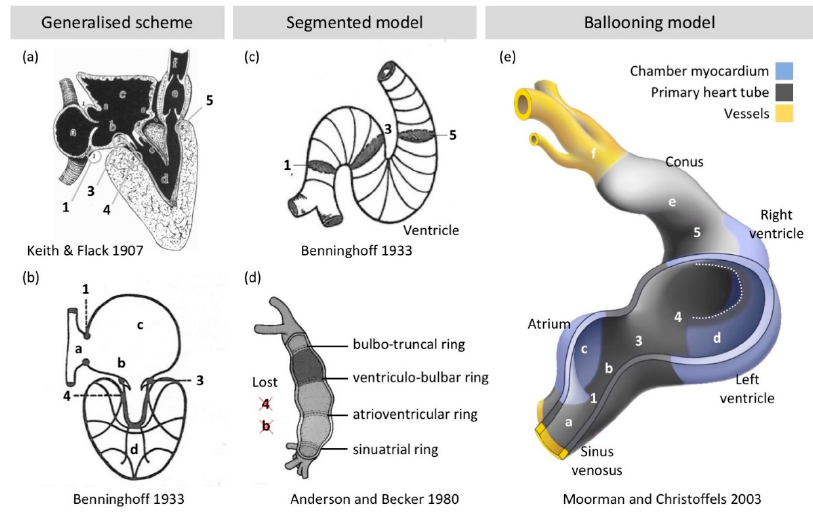
Figure 2. Building plan of the heart. ( a ) Keith and Flack [30] developed a “generalized” scheme of the vertebrate heart where the primitive parts (1,b,3,4,5) form a single domain (although their scheme is much inspired by the formed fish heart in which it is often the case that the atrioventricular part (3,4) is separated from the conal or bulbar valve area (5) by chamber myocardium). ( b ) The scheme labels a–d and 1,3,4 are inserted by us such that they correspond to ( a ), the primitive parts (1,b,3,4) still form a single domain. ( c ) Benningho ff [31], when conceptualizing the development of the conduction system from a comparative perspective (and maintaining that ectotherms do not have a conduction system comparable to that found in mammals and birds), emphasized the “Ostienringe” (1,3,5)